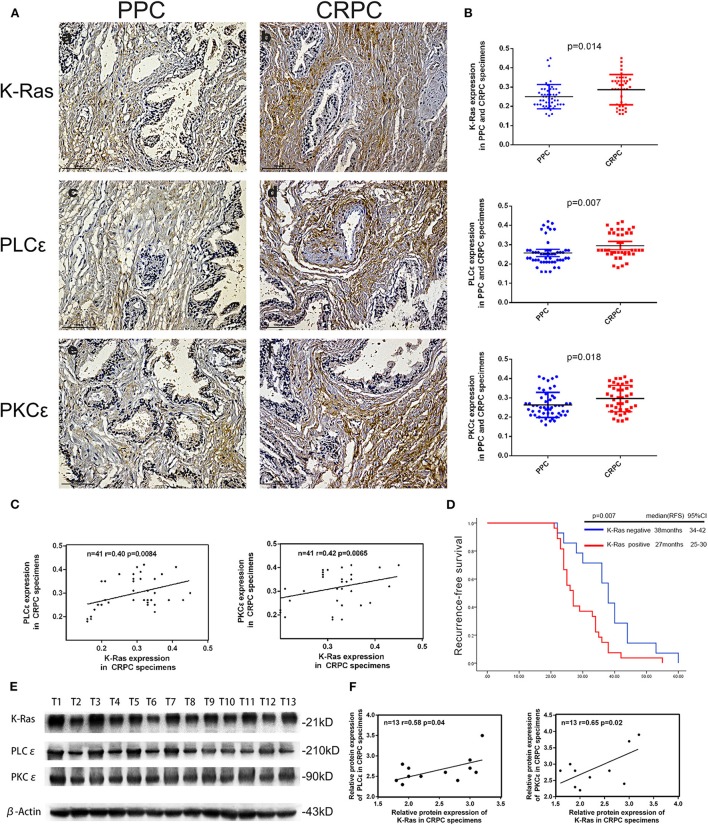
Expressions levels of K-Ras, PLCε, and PKCε in 50 PPC and 41 CRPC tumors. (A) K-Ras, PLCε, and PKCε expression in PPC and CRPC was detected by immunochemistry (magnification, ×200). (B) Image J was used to analyze the degree of tissue staining for K-Ras, PLCε, and PKCε in different tumor samples. (C) Correlation curve analysis for K-Ras staining scores vs. PLCε, PKCε staining scores in CRPC tissues. (D) The relationships of K-Ras with recurrence-free survival in CRPC patients. (E) Western blot was used to detect the protein expressions of K-Ras, PLCε, and PKCε in 13 CRPC tumor tissues; β-actin was used as a control. (F) Correlation curve analysis for the protein expressions of K-Ras vs. PLCε and PKCε in CRPC specimens. PLCε, phosphoinositide-specific phospholipase Cε. PKCε, protein kinase Cε. p < 0.05 was thought to be statistically significant.